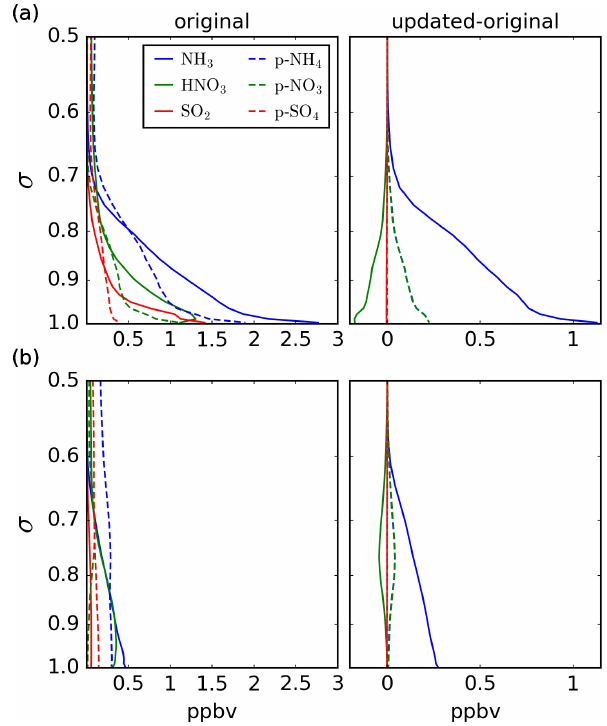
Figure 9. Monthly mean vertical profiles near (a) Toronto, Ontario, and (b) Grand Junction, Colorado, for May 2016. Plots on the left show mean profiles for GEM-MACH run with the original ammonia emissions, while plots on the right show mean differences between the updated and original runs. The vertical coordinate σ is the ratio of the pressure to the surface pressure. The legend in the upper left plot applies to all